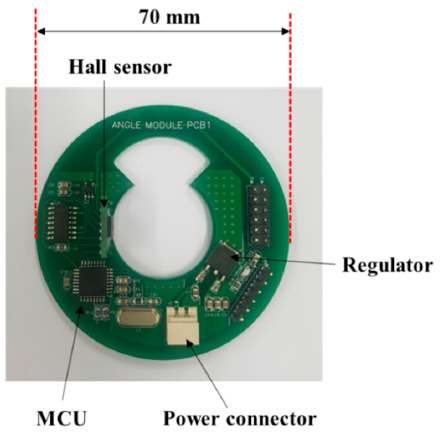
Figure 6. Fabricated angle sensor module.